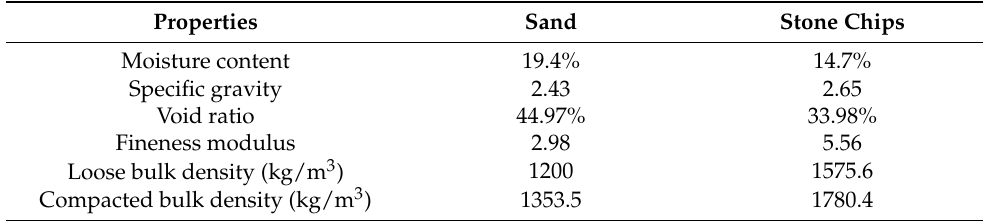
Table 2. Physical properties of aggregates.